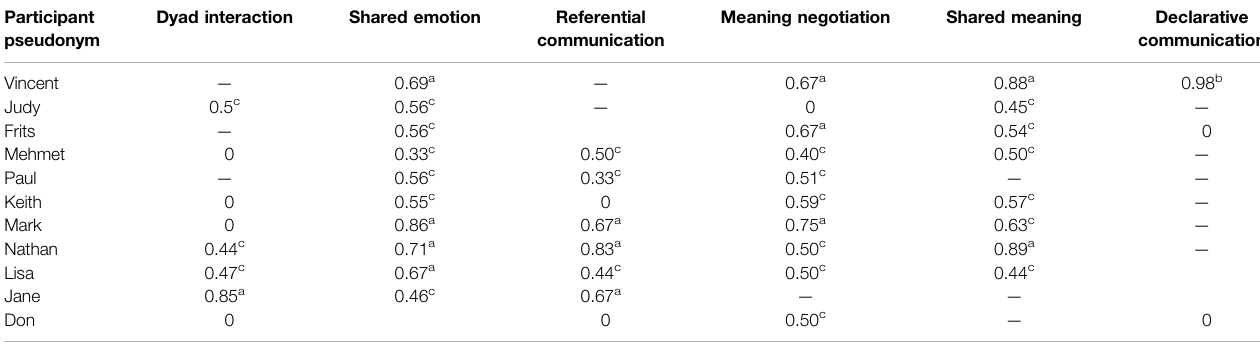
TABLE 5 | Effect sizes of targeted communication categories, based on a comparison between the combined intervention phases and the baseline phase. Participant